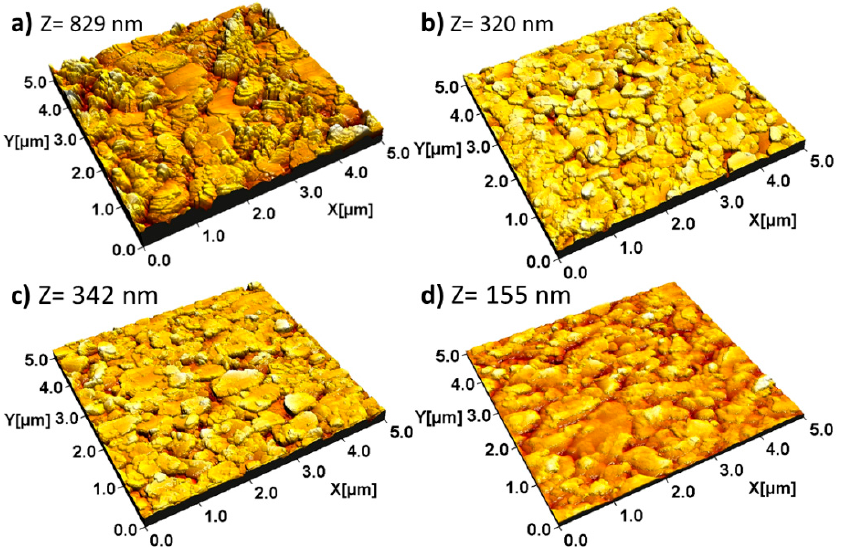
Figure 6. AFM images of ( a ) the paper substrate, and an inkjet-printed copper acetate film on this substrate with a print density of ( b ) 2028 drops/mm 2 ; ( c ) 4056 drops/mm2; and ( d ) 6084 drops/mm 2 .